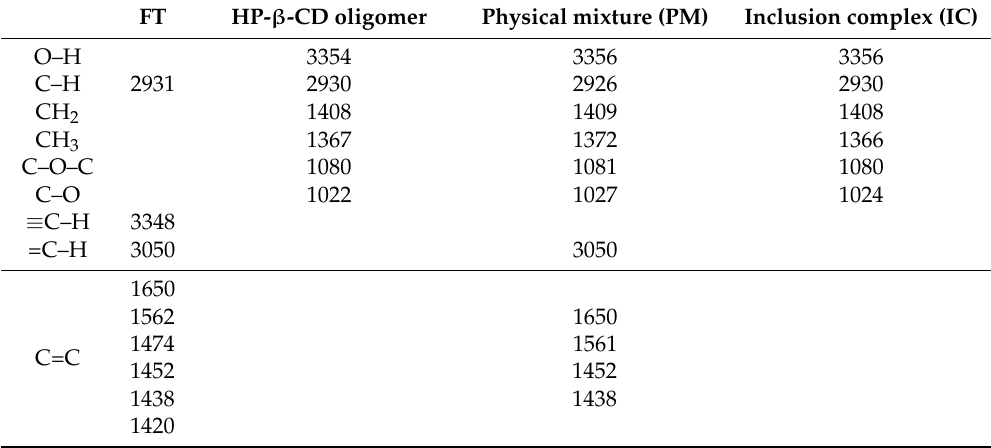
Figure 6. FT-IR spectra FT (black), HP- β -CD-ol (orange), PM (green), and IC (red). ( a ) Spectra were acquired between 4000 and 650 cm −1 ; ( b ) Spectra were acquired between 1700 and 650 cm −1 . Table 2. FT-IR absorption bands for FT, HP-β-CD-ol, PM, and IC.